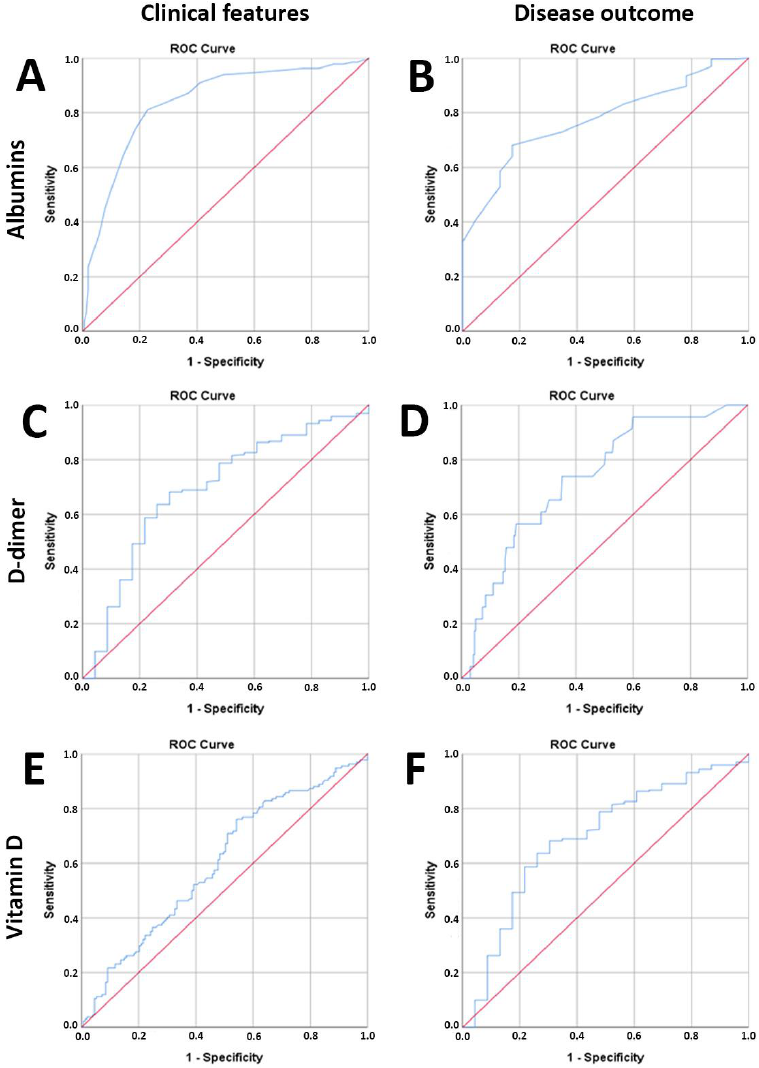
Figure 4. ROC analysis of albumin, D-dimer, and vitamin D as predictor parameters for evaluating the severity of the clinical picture and the outcome of the disease. The patients were divided into groups with mild (n = 134) and severe (n = 154) clinical pictures as well as groups with favorable (n = 265) and fatal (n = 23) disease outcomes. The serum values of the examined biochemical parameters were obtained from blood samples immediately after admission to the hospital for treatment. ( A ) Serum albumin values indicate the development of a severe clinical picture and ( B ) a lethal outcome. ( C ) Serum D-dimer values indicate the development of a severe clinical picture and ( D ) a fatal outcome. ( E ) Values of serum vitamin D indicate the development of a severe clinical picture and ( F ) a lethal outcome. Statistical significance was determined using the ROC curve. Values of p < 0.05 were considered statistically